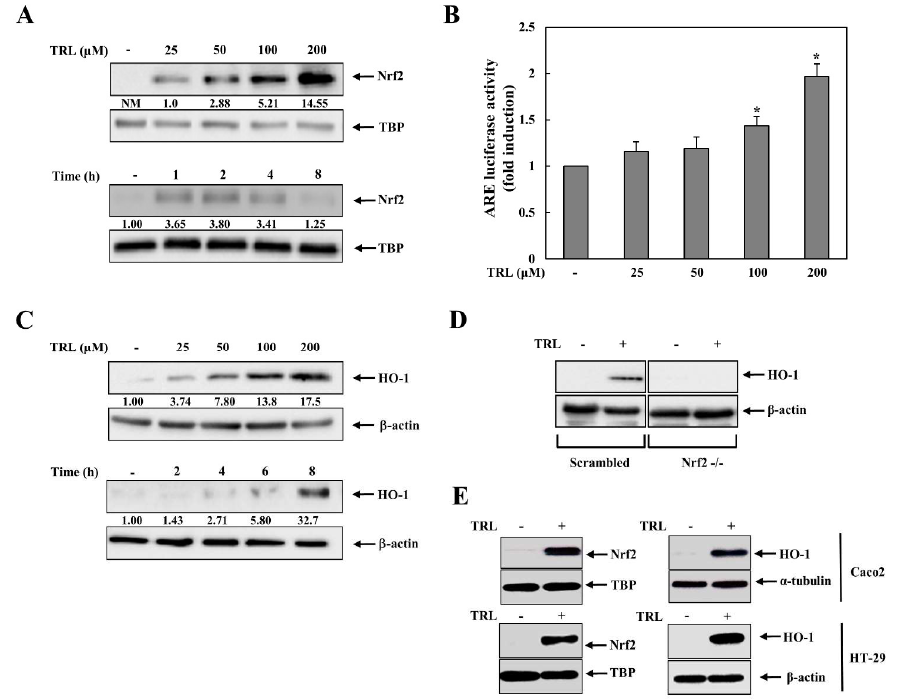
Figure 1. Tranilast (TRL) activates the Nrf2-HO-1 pathway. ( A ) Upper panel: HCT116 cells were treated with various concentrations of TRL for 2 h. The nuclear Nrf2 protein levels were assessed by western blotting. Lower panel: HCT116 cells were treated with TRL (200 μM) for the indicated times. The nuclear Nrf2 protein levels were assessed by western blotting. ( B ) Upper panel: HCT116 cells were treated with various concentrations of TRL for 8 h. The hemeoxygenase-1 (HO-1) protein levels were assessed by western blotting. Lower panel: HCT116 cells were treated with TRL (200 μM) for the indicated times. The HO-1 protein levels were assessed by western blotting. ( C ) HCT116 cells were cotransfected with an ARE-responsive luciferase reporter plasmid and a CMV Renilla luciferase plasmid for 24 h. The cells were treated with various concentrations of TRL for 8 h and ARE-responsive luciferase activity was measured and normalized to CMV Renilla luciferase activity. ( D) Control (scrambled) and Nrf2-knockdown HCT116 cells (Nrf2-/-) were treated with TRL (200 μM) for 8 h. The HO-1 protein levels were assessed by western blotting. [E] Caco-2 cells and HT-29 cells were treated with TRL (200 μM). The nuclear Nrf2 and HO-1 protein levels were assessed after 2 and 8 h, respectively, by western blotting. For western blotting in ( A ), ( C ), ( D ), and ( E ), equivalent loading of proteins was verified using TATA box protein (TBP) for nuclear Nrf2 protein and β -actin for HO-1 protein. NM, not measurable. The data in ( B ) are presented as mean ± standard deviation ( n = 3) *: p < 0.05 vs.